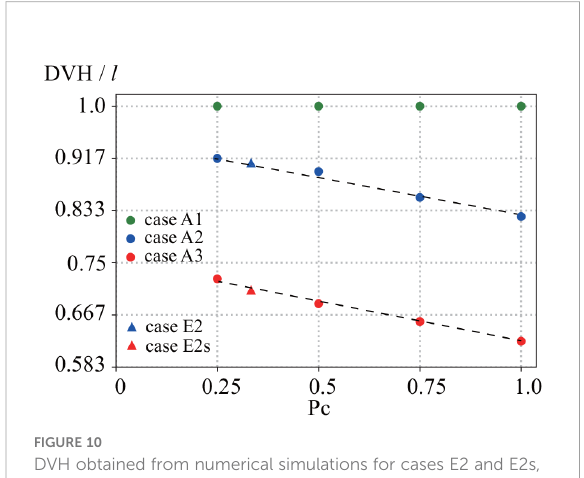
FIGURE 10 DVH obtained from numerical simulations for cases E2 and E2s, and cases A1 to A3. Broken lines indicate the approximate straight lines obtained using the least-squares method.